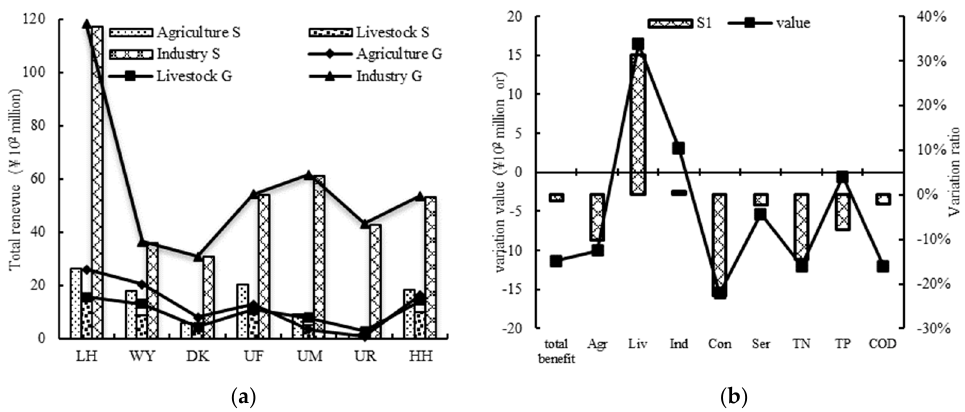
Figure 15. Actual vs. planned 2012–2016 under scenario S1 (Agr: agricultural, Liv: livestock, Ind: industry, Con: construction, Ser: services). ( a ) Comparison of industrial output value by district and county (S: actual G: planned). ( b ) Comparison of total output value in Bayan Nur City.